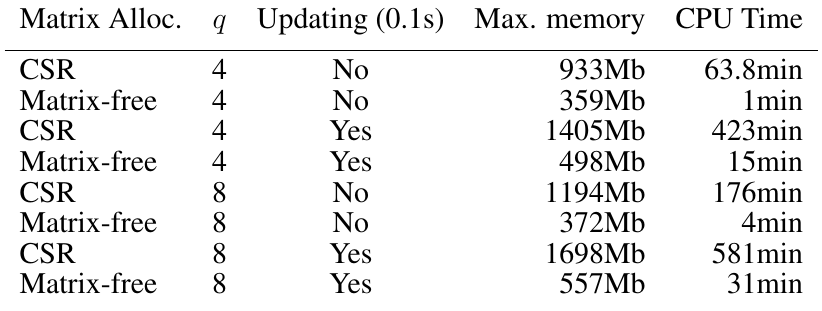
Table 3: Matrix-free strategy vs Allocation matrix (CSR) implementation performance. Matrix